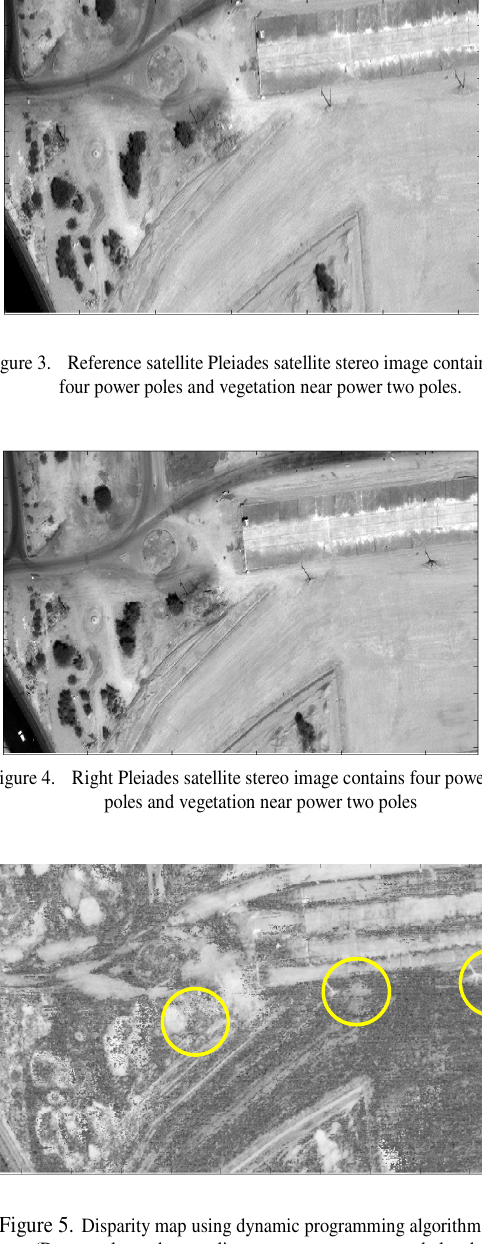
Figure 5. Disparity map using dynamic programming algorithm (Detect poles and power lines seems some extent and also the vegetation in white color).